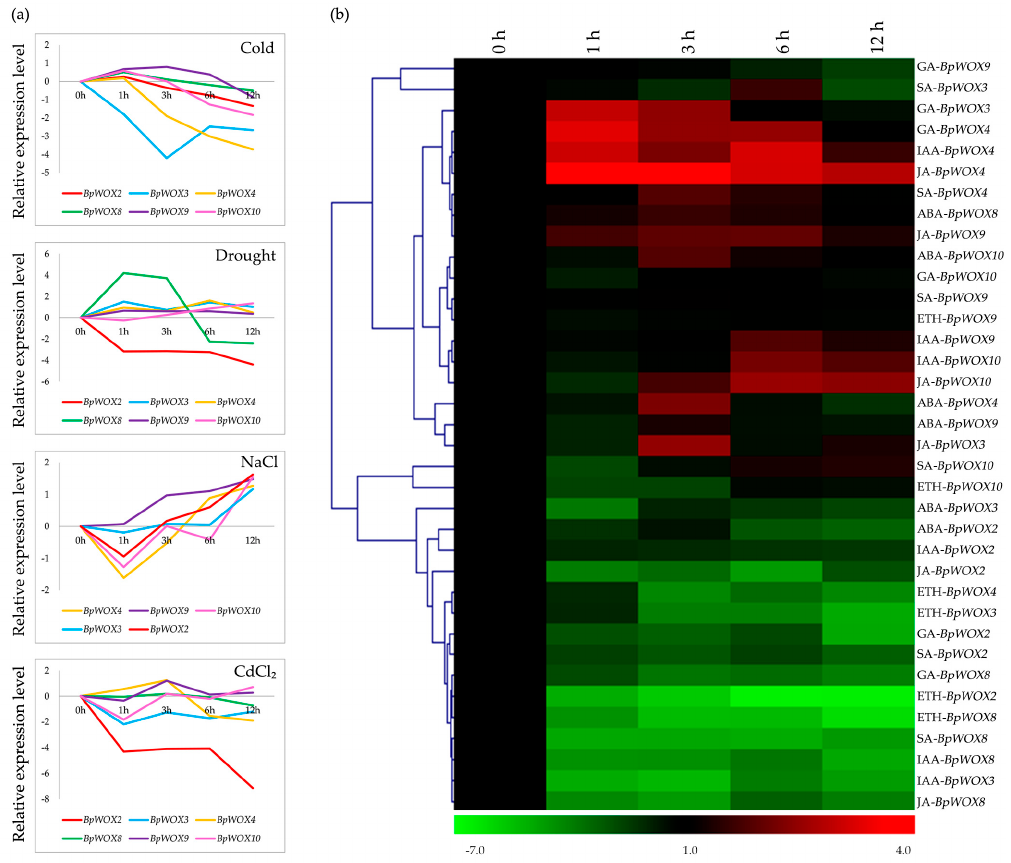
Figure 7. The BpWOX genes respond to the environmental stresses. ( a ) The expression pattern of BpWOX gene under four environmental conditions. For cold treatment, the seedlings were transferred into a 4 °C growth chamber. For salt and CdCl 2 treatments, the seedlings were washed carefully and transferred into a solution of 200 mM NaCl and 50 µM CdCl 2 , respectively. For drought treatment, we used 20% ( w / v ) PEG solution to simulate drought condition. BpWOX2 was labeled with a red line, BpWOX3 was labeled with a blue line, BpWOX4 was labeled with a yellow line, BpWOX8 was labeled with a green line, BpWOX9 was labeled with a purple line, and BpWOX10 was labeled with a pink line; ( b ) A heat map of BpWOX genes responding to phytohormones at the transcription level. For phytohormone treatments, 100 µM solution of IAA, GA, SA, Me-JA, ETH, and ABA were sprayed onto the surface of the seedlings, respectively. Transcript levels were determined by qRT-PCR, and the expression of BpGAPDH was used as an internal control.